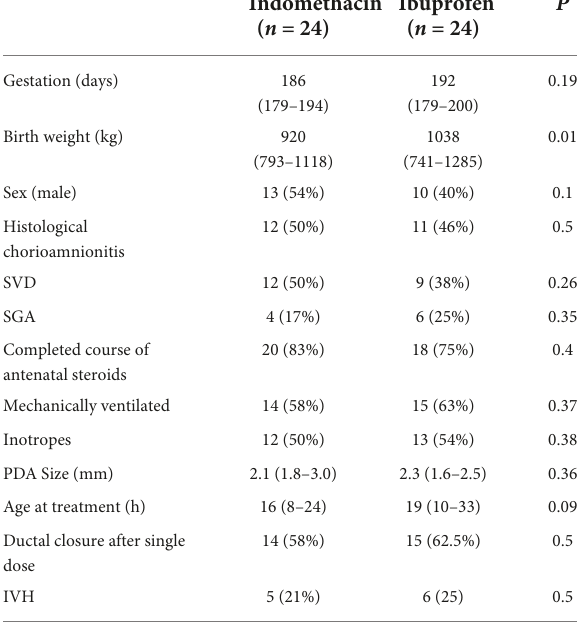
TABLE 1 Clinical